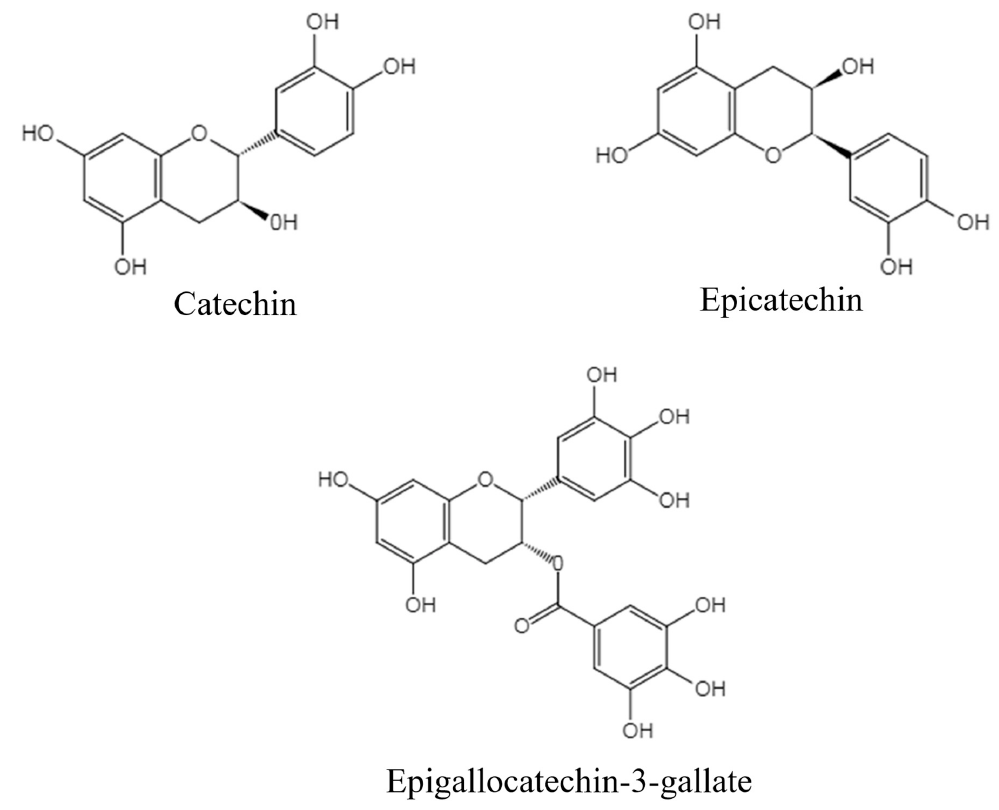
Figure 1. The chemical structures of main catechins in tea associated with cardiovascular disease (CVD)